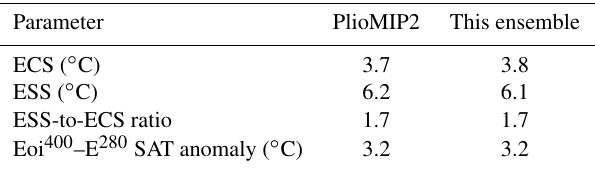
Table 1. A comparison of climate parameters between the PlioMIP2 ensemble and the subgroup of PlioMIP2 models used